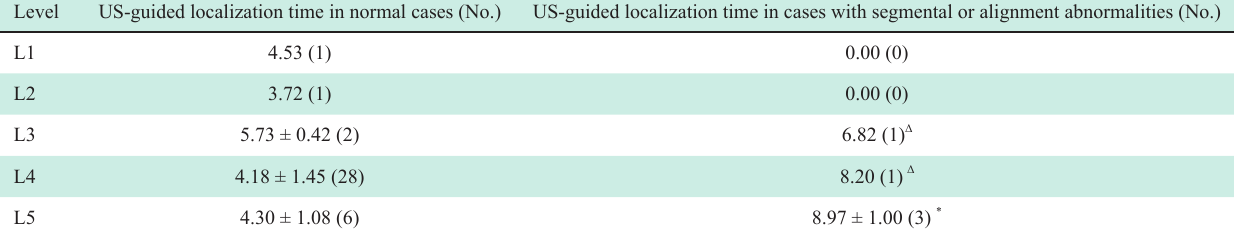
Table 2 US-guided segmental localization time for different lumbar vertebrae Level US-guided localization time in normal cases (No.)